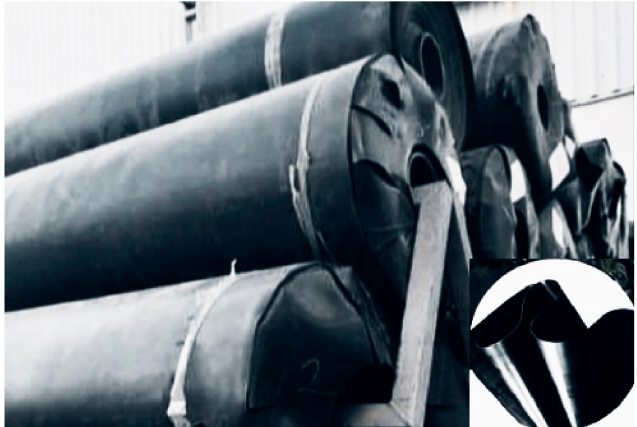
Figure 1. Geomembrane used in the manufacture of biodigesters.